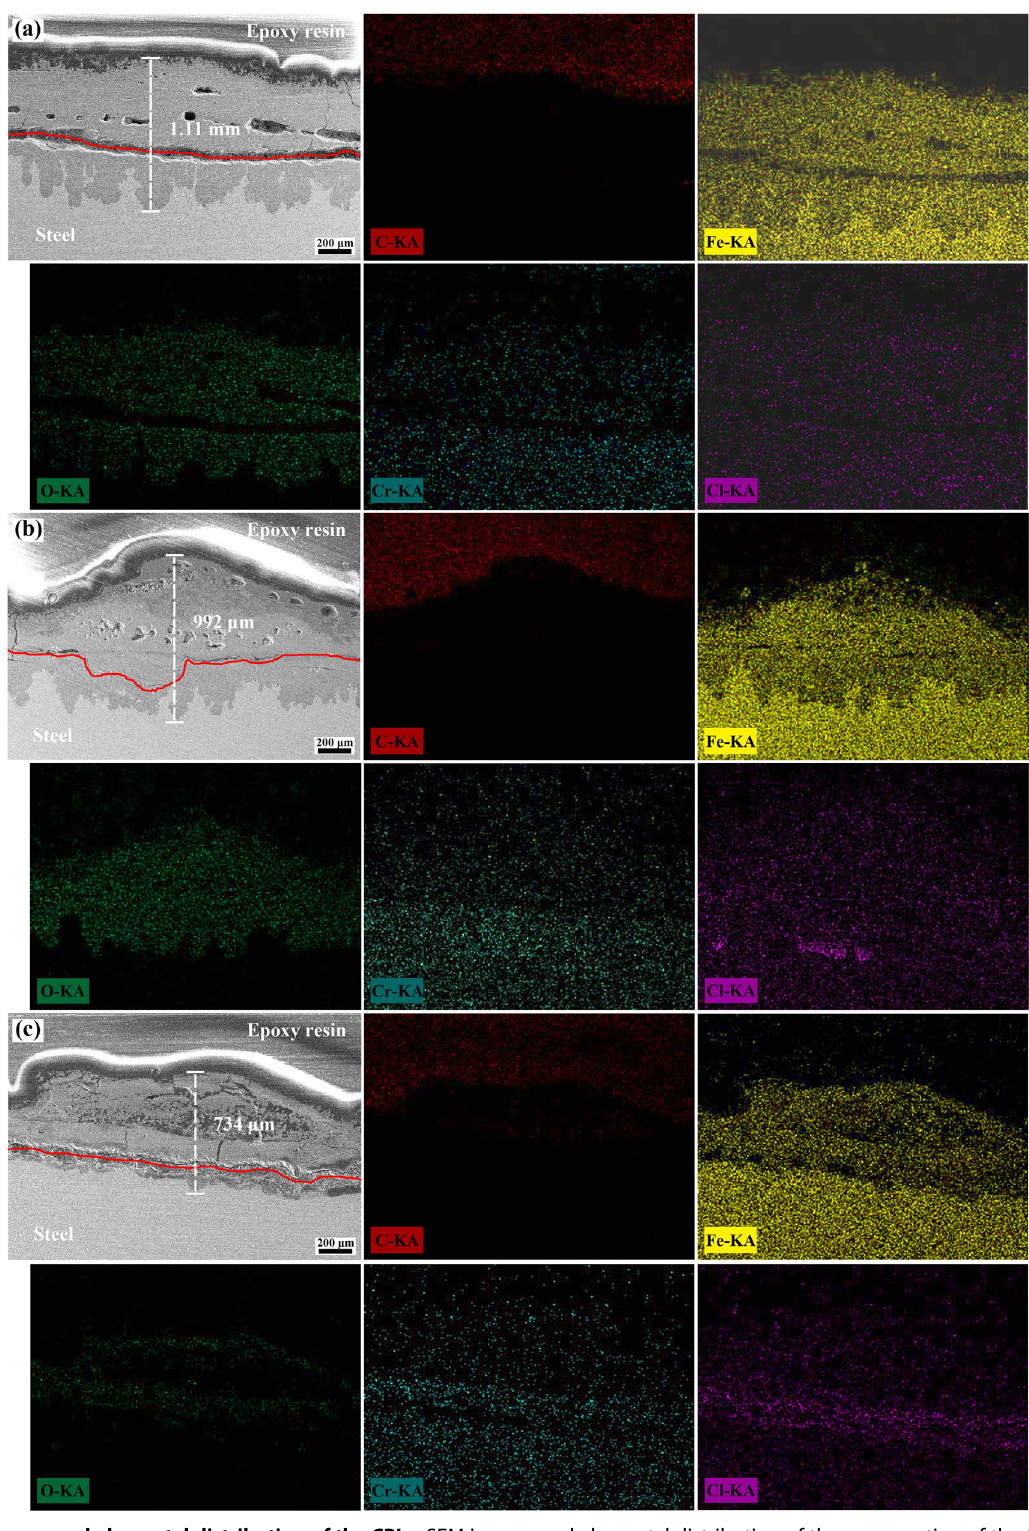
Fig. 3 SEM images and elemental distribution of the CPLs. SEM images and elemental distribution of the cross-section of the CPL formed on the surface of the AISI 4135 steel coupons after exposure to the a HTL, b MTL, and c LTL for 3 months. limited, as evidenced by the clear distribution of chlorine in the be divided into inner and outer layers, and many holes and cracks inner and outer layers (Fig. 3). In addition, the elemental were present in the CPLs. These CPLs with layered structures, distribution also shows that the corrosion products were rich in holes and cracks mean that their inhibitory effect on the Cr and Fe. The high content of Cr in corrosion products implies penetration of corrosive species, especially small-radius Cl – , is npj Materials Degradation (2022) 96 Published in partnership with CSCP and